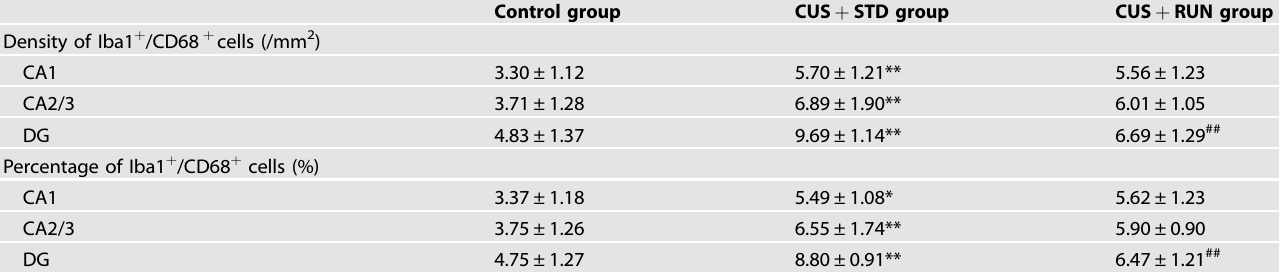
Table 5. Density and percentage of Iba1 + /CD68 +